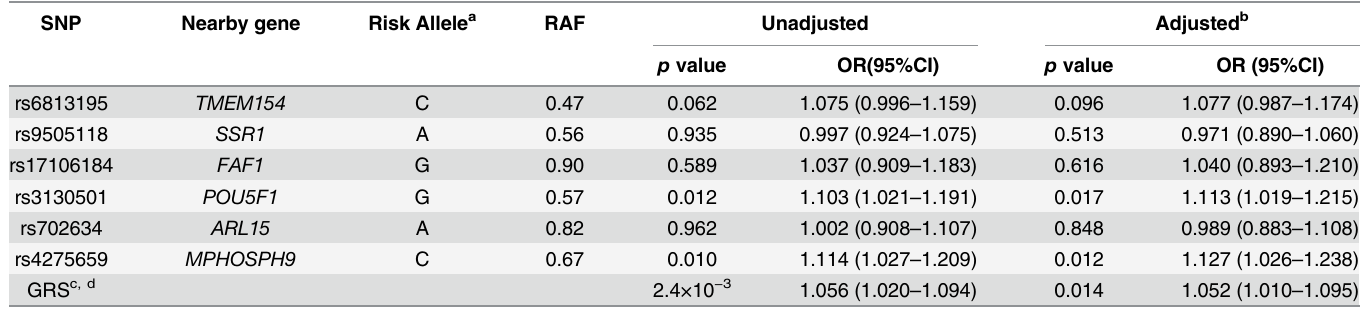
Table 2. Association of 6 SNP loci with type 2 diabetes in a Japanese population.